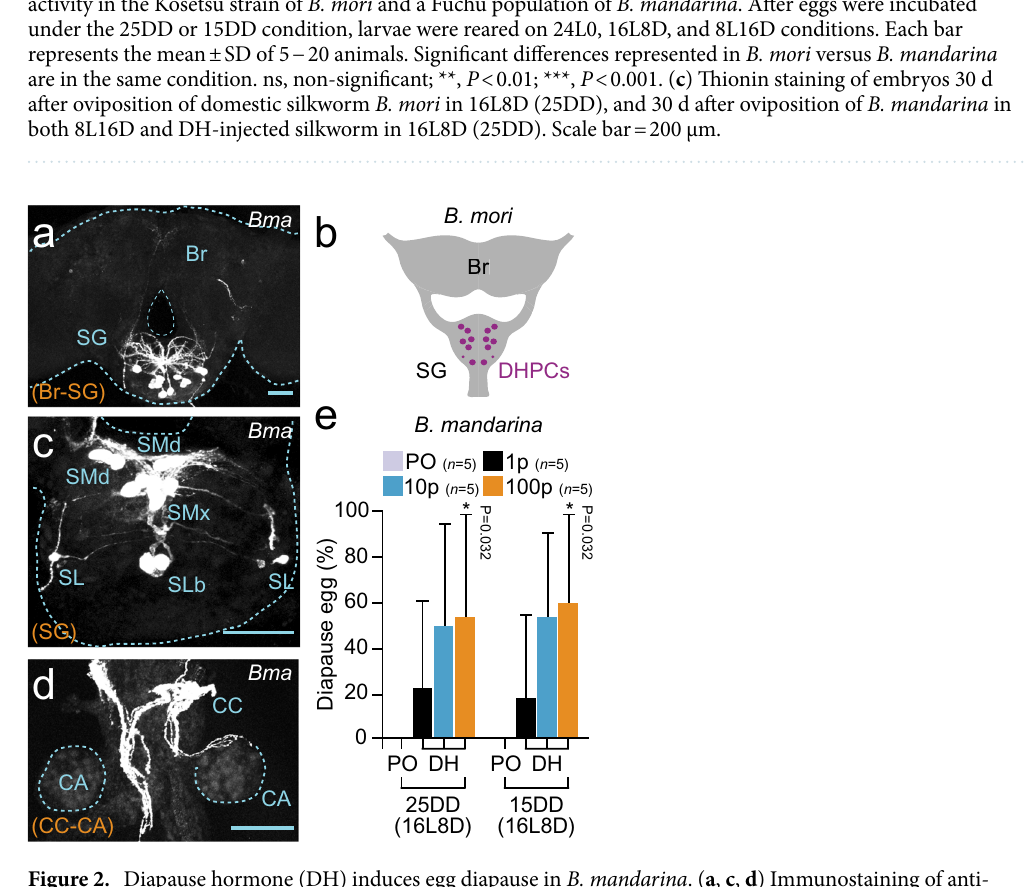
Figure 2. Diapause hormone (DH) induces egg diapause in B. mandarina . ( a , c , d ) Immunostaining of anti- DH[N] antibody in brain-subesophageal ganglion (SG) complex ( a ), SG ( c ), and corpus allatum (CA) − corpus cardiacum (CC) complex ( d ) of B. mandarina pupa Tissues were dissected out on 1 d after pupation from 8L16D (25DD) pupae. Scale bar = 100 µm. ( b ) Schematic drawing of pupal brain–SG complex in Bombyx mori . DH is produced in DH-PBAN-producing neurosecretory cells (DHPCs) located within the SG. ( e ) Diapause egg-inducing activity of DH injection. Peanut oil (PO) or each DH peptide concentration (1, 10, or 100 pmol) was injected into B. mandarina pupa reared under the 16L8D condition from 25 and 15DD embryos, and diapause egg-inducing activity was measured. Each bar represents the mean ± SD of five animals. Asterisks indicate significant differences versus PO injection. *, P <